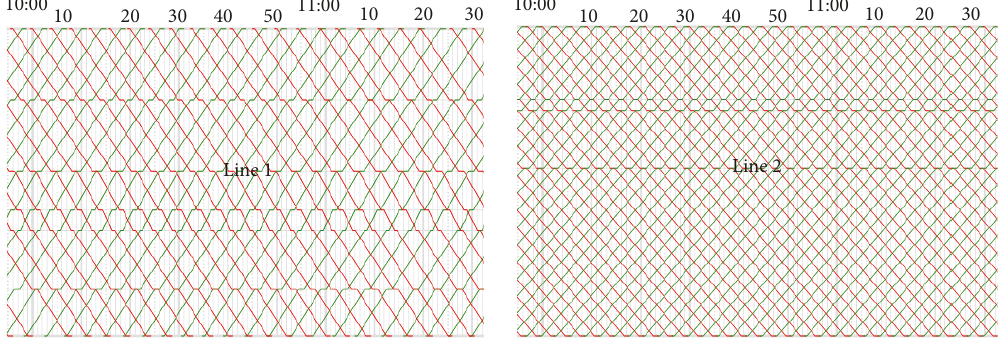
Figure 8: The partial train diagram of each metro line. The horizontal axis denotes the time. For example, the “10” after the “10:00” indicates the time of 10:10, and so on.